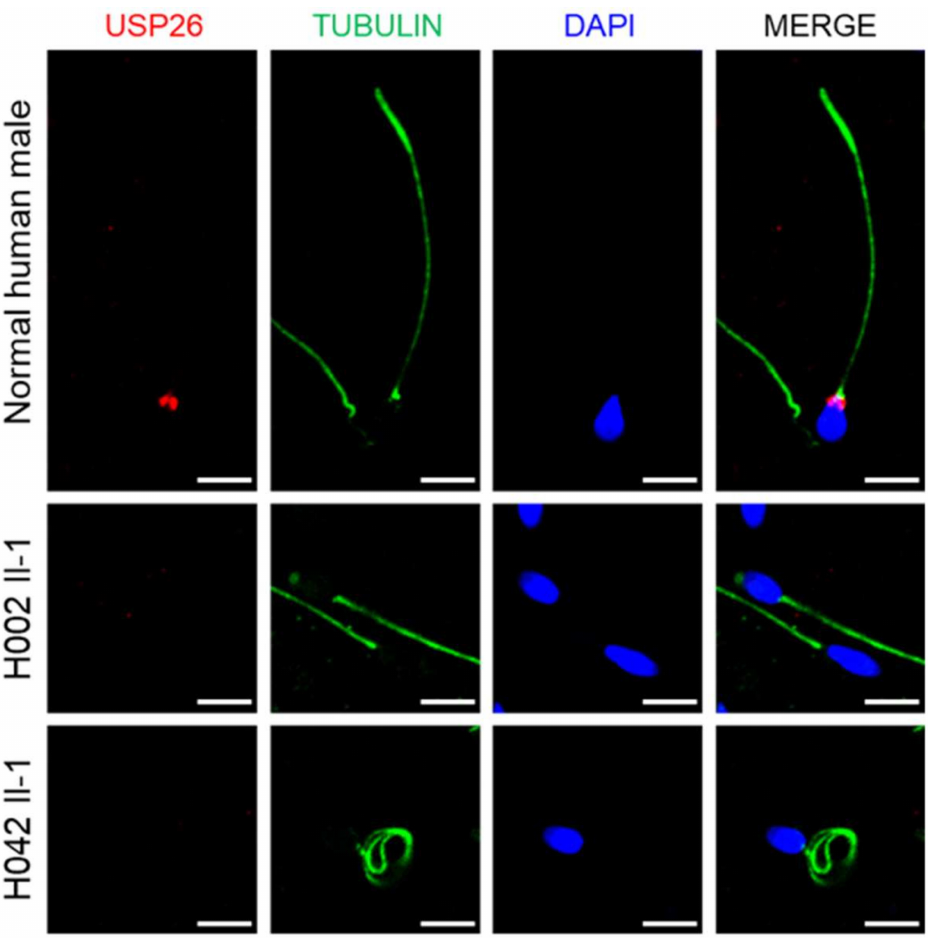
Figure 4. Immunofluorescence staining of USP26 in the spermatozoa from a normal male control and men harboring hemizygous USP26 variants. The sperm cells were stained with anti-USP26 (red) and anti-a-tubulin (green) antibodies. DNA was counterstained with DAPI (4 (cid:48) ,6-diamidino-2- phenylindole) as a marker of the cell nucleus. Scale bars: 5